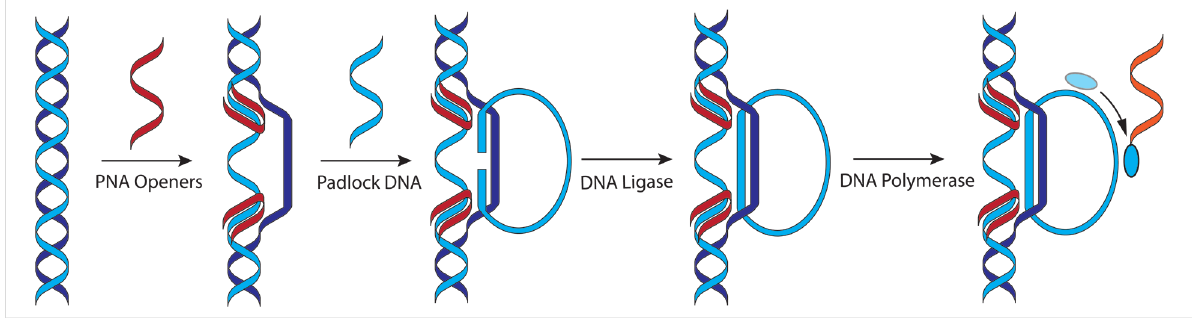
Figure 22: Rolling circle amplification using PNA openers (red) to invade a dsDNA target forming a P-loop. A padlock DNA probe (blue) can bind to the DNA liberated by the PNA openers. Ligase circularizes the padlock DNA resulting in an earring complex which acts as a primer for DNA poly- merase. The resulting rolling circle amplification product (orange) can then be isolated or detected in